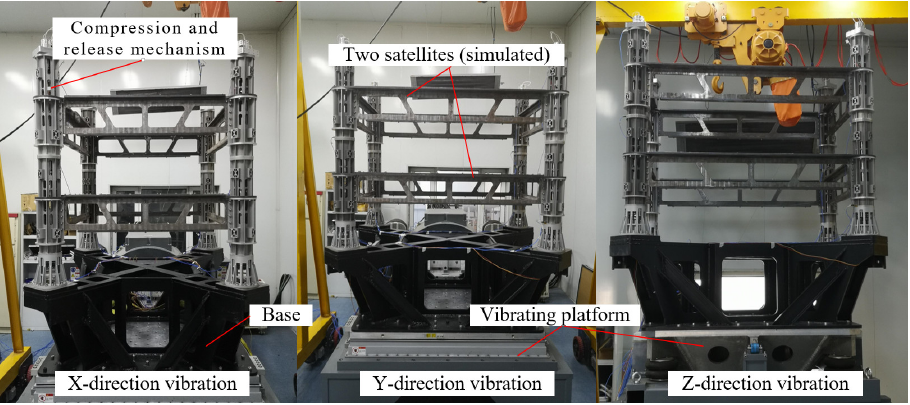
Figure 16. Vibration test. Table 2. Random vibration test conditions for system compression state.